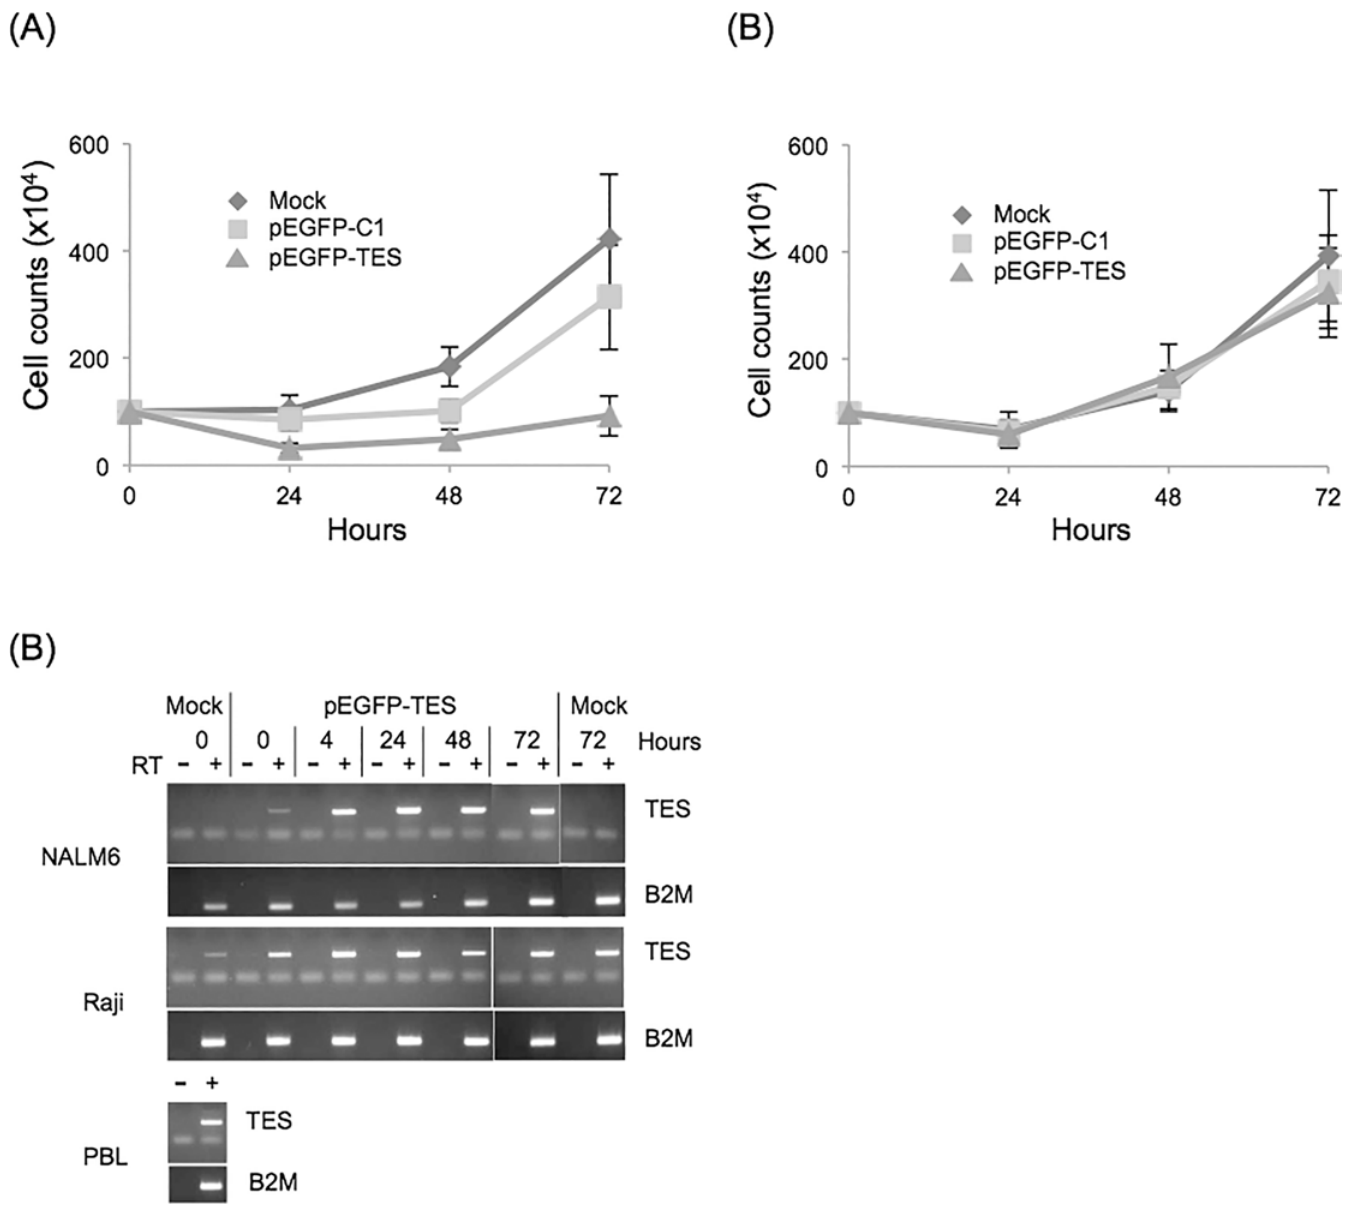
Fig 3. TES transfection induces rapid expression and reduced proliferation in NALM6 cells compared to Raji cells. Cells were transfected with mock, pEGFP-C1 or pEGFP-TES expression plasmids, cultured and counted after trypan blue staining; (A) NALM6 (n = 5) and (B) Raji (n = 3) cells (error bars are standard errors). (C) RT-PCR of transfected cells showing rapid, robust TES expression after pEGFP-TES transfection. PBL cDNA and genomic DNA were included as controls. In addition, RT negative samples were included to confirm removal of contaminating transfected plasmid and genomic